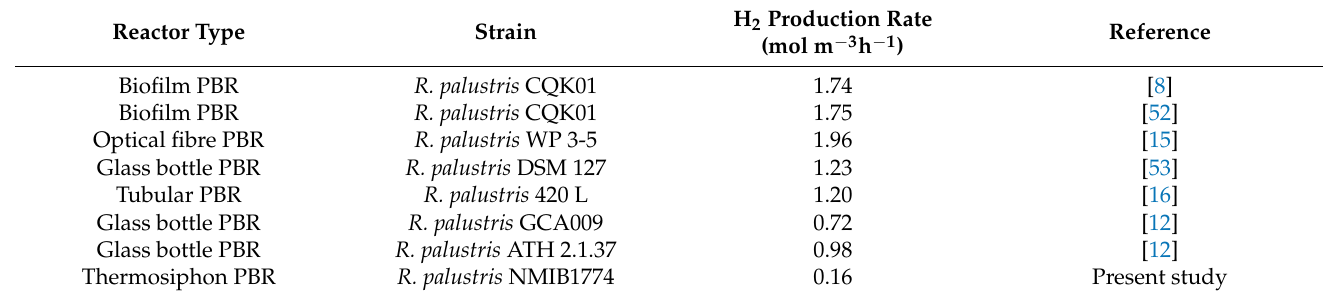
Table 3. Comparison of hydrogen production rates of various R. palustris strains in other